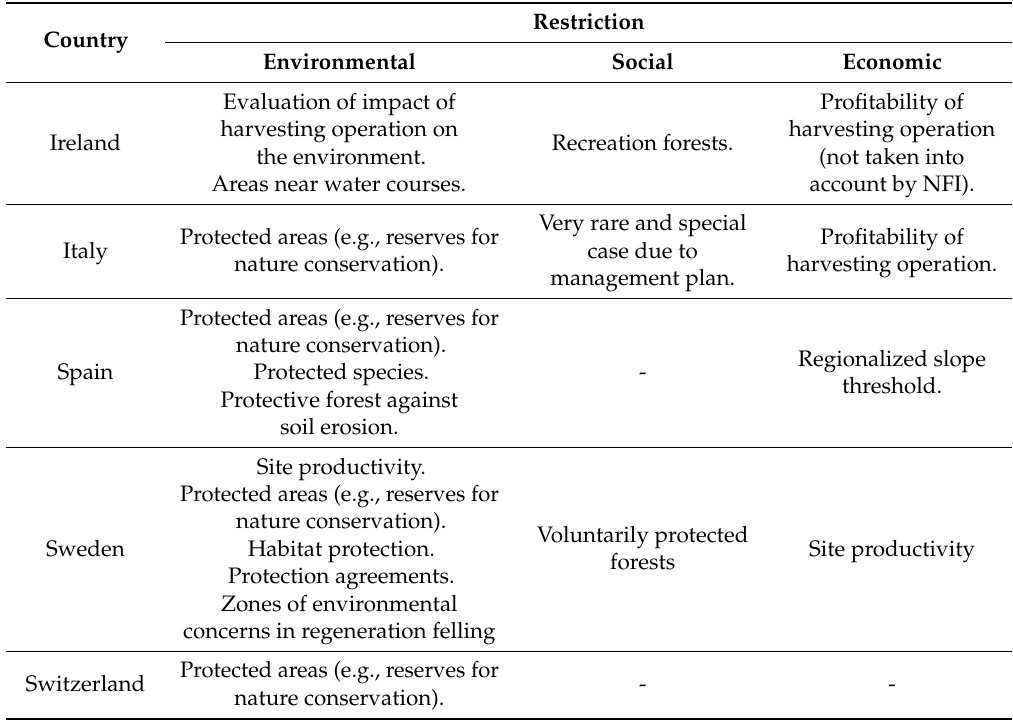
Table 5. Summary table of the environmental, social and economic restrictions within each